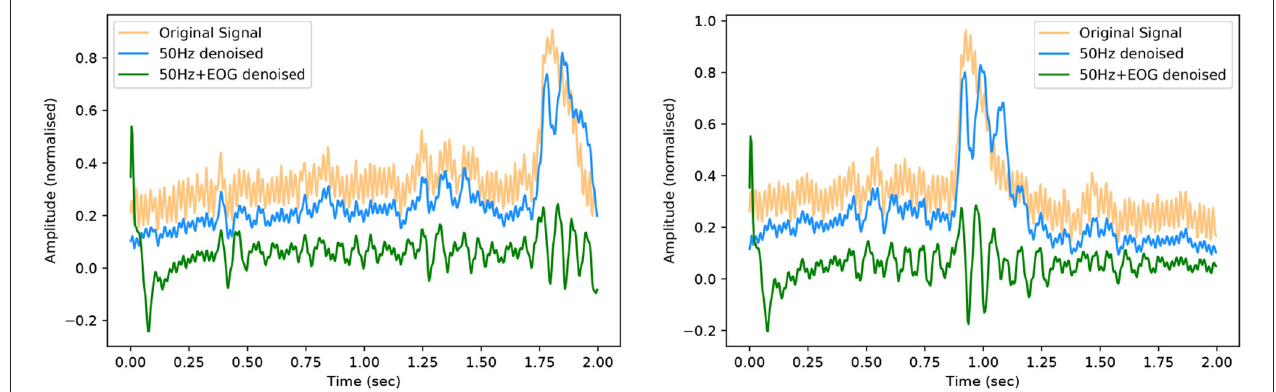
FIGURE 12 | Denoised EEG signals following 50 Hz and EOG artefact